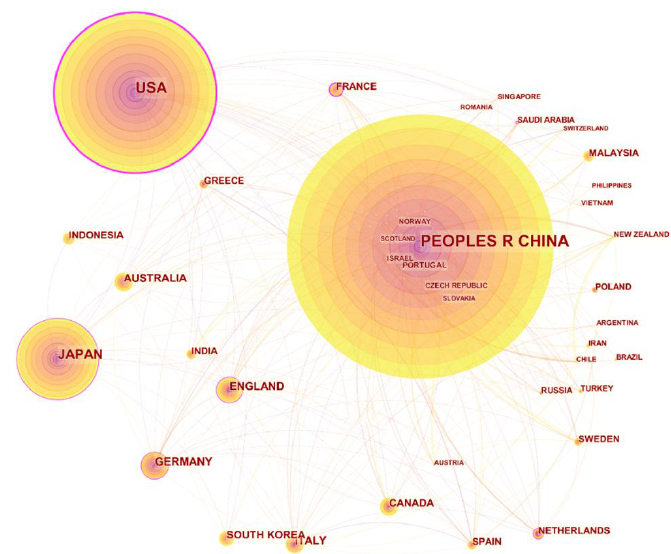
Figure 3. Network of countries.